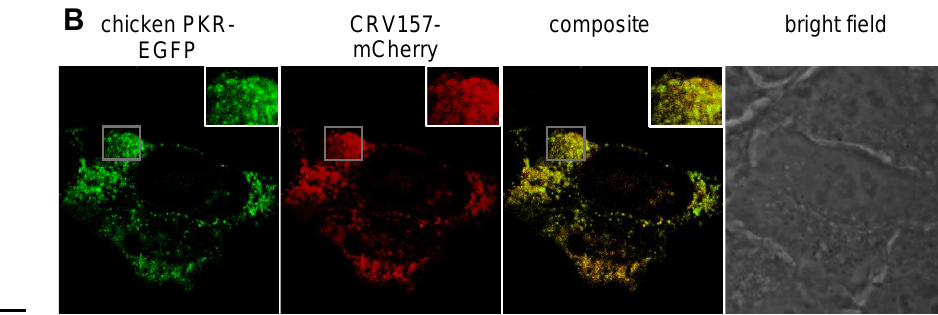
Figure 6. Co-localization of CRV157 with chicken PKR. ( A ) HeLa PKRkd cells were co-transfected with plasmids expressing PKR-EGFP (0.5 µg) (green) and CRV157-mCherry (0.5 µg) (red). Fixed and permeabilized cells were subjected to confocal microscopy. ( A ) Results of quantitative colocalization analysis (QCA) indicating the degree of colocalization of CRV157 and chicken PKR. An average of the Pearson correlation coefficients (PCC) was calculated with 15 representative samples of three independent experiments. The error bar indicates the standard deviation. ( B ) Colocalization of CRV157 and chicken PKR is shown by the overlap of signals in the composite, which results in a yellow signal. Data shown are representative images from three independent experiments. The insets represent the boxed areas.